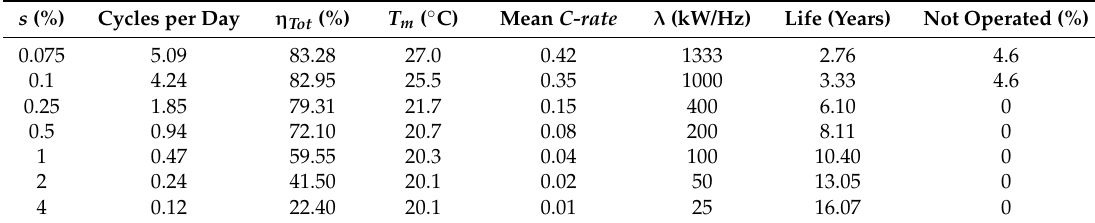
Table 5. PFC results: C-rate = 1C, T 0 = 20 ◦ C.